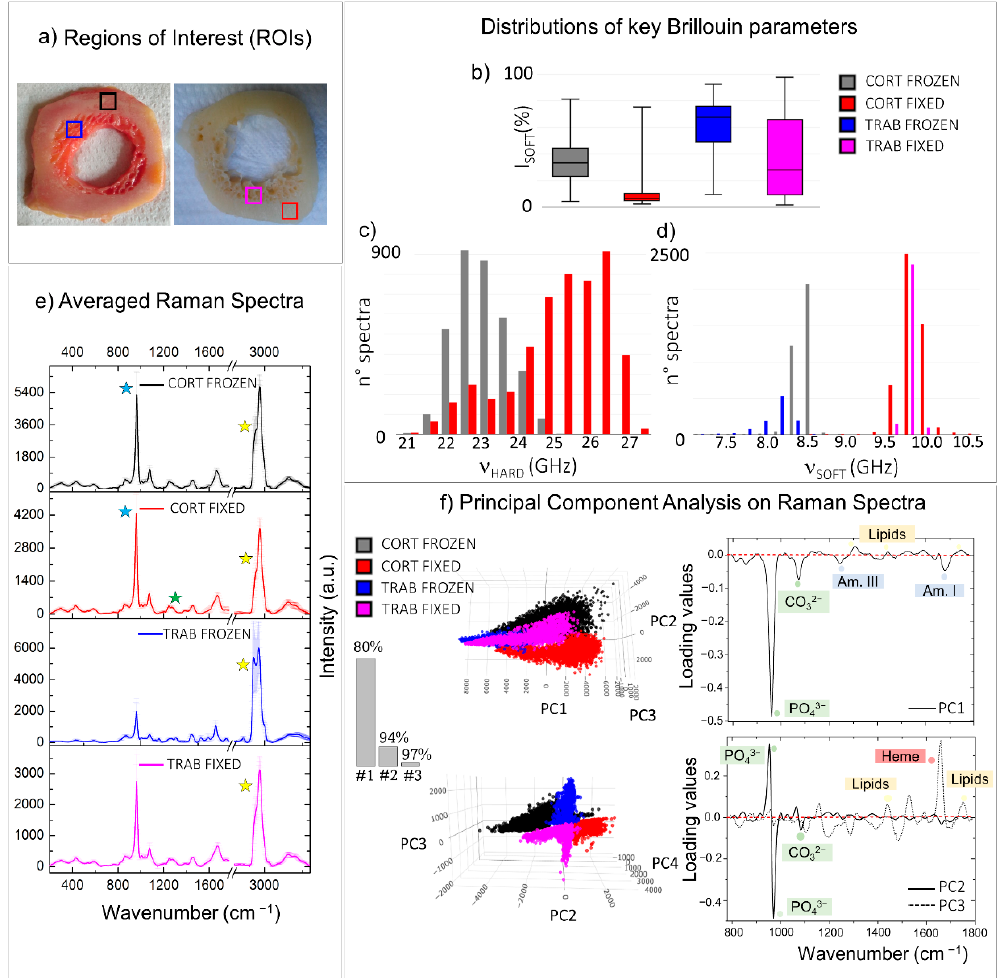
Figure 4. Comparison between regions of interest (ROIs) collected from two similar histological sections treated with different preparation processes. ( a ) Pictures of two diaphyseal cross-sections treated with two distinct sample preparation processes: freezing at -80 °C (on the left) and PFA-fixation followed by ethanol storage (on the right). The coloured squares enclose ROIs selected for comparisons (black: frozen cortical bone; red: fixed cortical bone; blue: frozen trabecular bone; magenta: fixed trabecular bone). Box plots and histograms report the statistical distributions of relevant Brillouin parameters obtained from the ROIs, namely ( b ) the relative percentage of the P SOFT component, ( c ) the frequency shift ν HARD of the P HARD component, and ( d ) its frequency shift ν SOFT . ( e ) Average of all the normalized Raman spectra obtained from the ROIs. The y-error bars represent the standard deviation of Raman intensities calculated for each of the four datasets. ( f ) Score plots and loading plots of the principal component analysis performed on the Raman spectra of ROIs. Coloured labels in the loading plots are used to stress the presence of spectral features referable to a certain class of macromolecules. The histogram reports the cumulative variance expressed by the first (1#), the second (#2), and the third (#3) principal components.